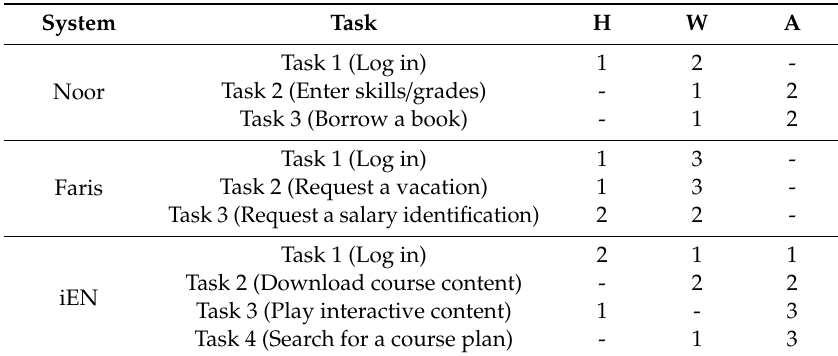
Table 12. User feelings criteria: happy and confident (H), a little bit confused and worried (W), and afraid and not happy